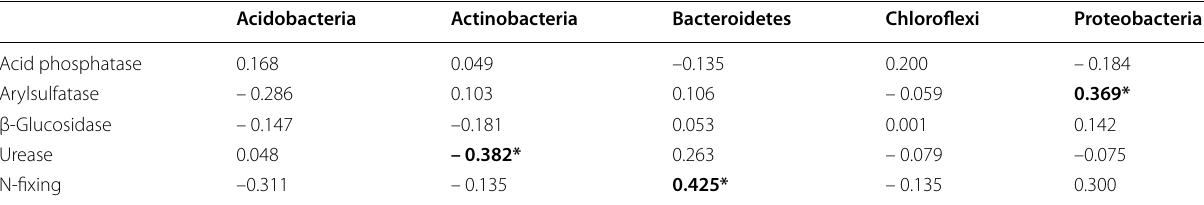
Table 3 Pearson correlation between enzymatic activity and bacterial community